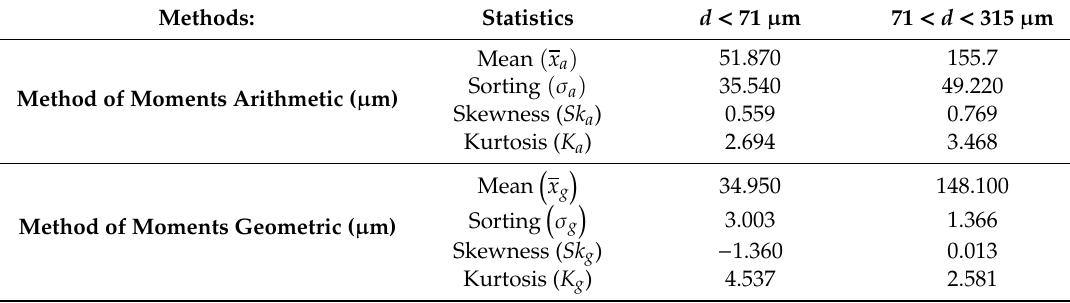
Figure 2. (A) The measured particle size distribution curve by laser diffraction in an aqueous suspension containing smaller than 71 μ m of microcline particles ( d < 71 μ m). (B) The measured particle size distribution curve by laser diffraction in an aqueous suspension containing microcline particles in the range from 71 μ m up to 315 μ m (71 μ m < d < 3 15 μ m).